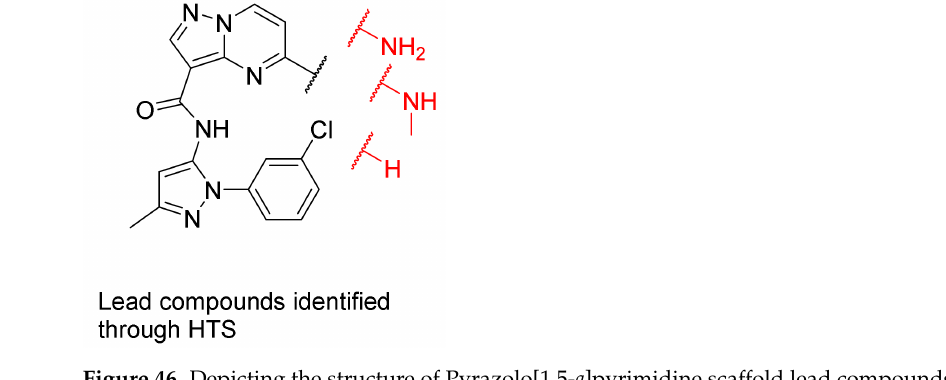
Figure 46. Depicting the structure of Pyrazolo[1,5- a ]pyrimidine scaffold lead compounds discovered through